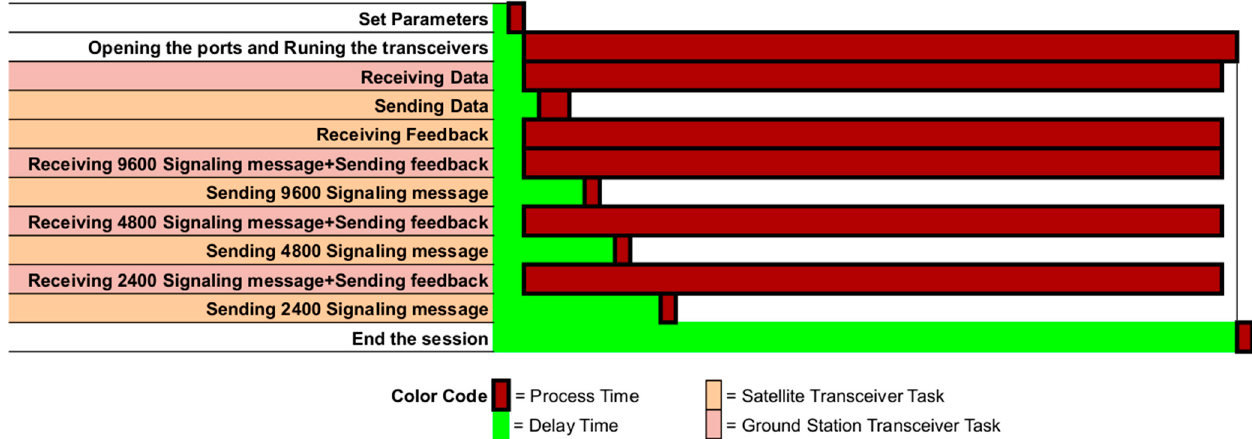
Figure 6. Data input block. The output data is directed to TCP network ports, and the Socket PDU block of GNU Radio shown in Figure 7 is used for this task. Figure 7. Data input block.